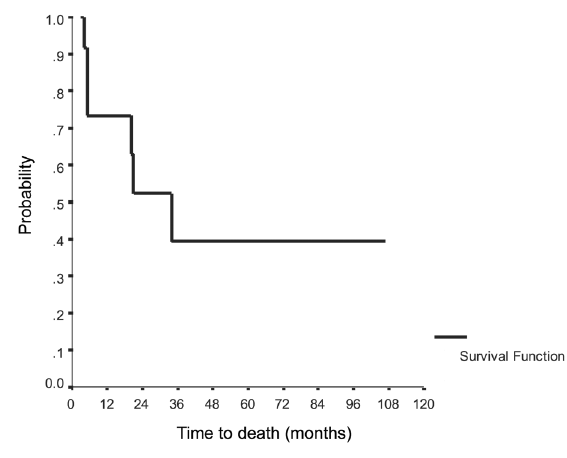
Figure 2 – Cancer specific survival. Figure 3 – Disease-free